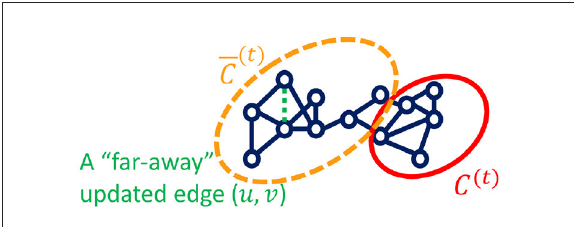
FIGURE2 Local cluster C ( t ) and a “far-away” edge to be filtered at time t